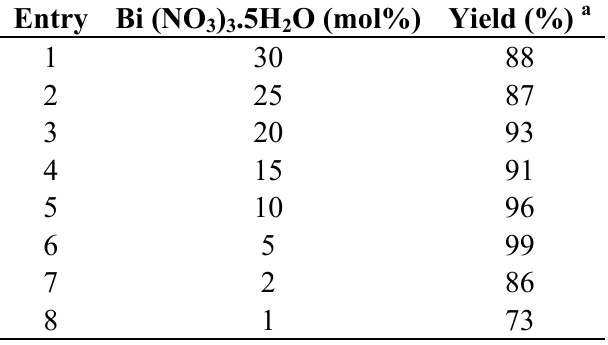
Table 2. Microwave-assisted one-pot, three component synthesis of 1,4-dihydropyridines from benzaldehyde (1 mmol), ethyl acetoacetate (2 mmol) and ammonium acetate (1 mmol) using bismuth nitrate pentahydrate as catalyst under solventless condition (1 minute): optimization of the amount of the catalyst.